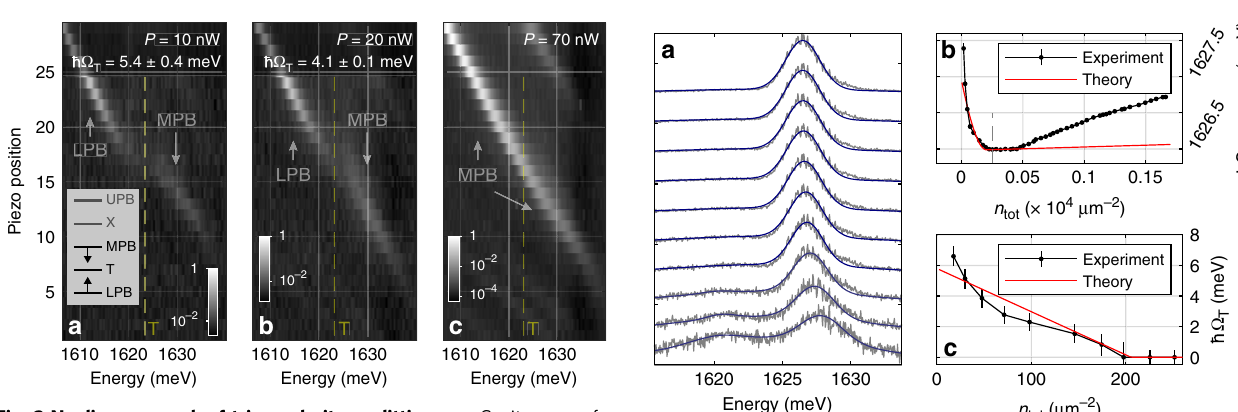
Fig. 2 Nonlinear quench of trion-polariton splitting. a – c Cavity scan of LG 00 mode across the trion resonance for different pump powers: 10, 20 and 70 nW, respectively. The peak energy of the pump laser is fi xed at ~1.62 eV. Pseudo-colour scale is logarithmic. Estimates for the trion Rabi splittings are obtained by fi tting extracted peak positions for each piezo step with a coupled oscillator model. Inset: schematic diagram showing how the energies MPB and LPB are renormalised in the case of phase space fi lling effect leading to reduction of Rabi-splitting between trion level and the bare photon mode.